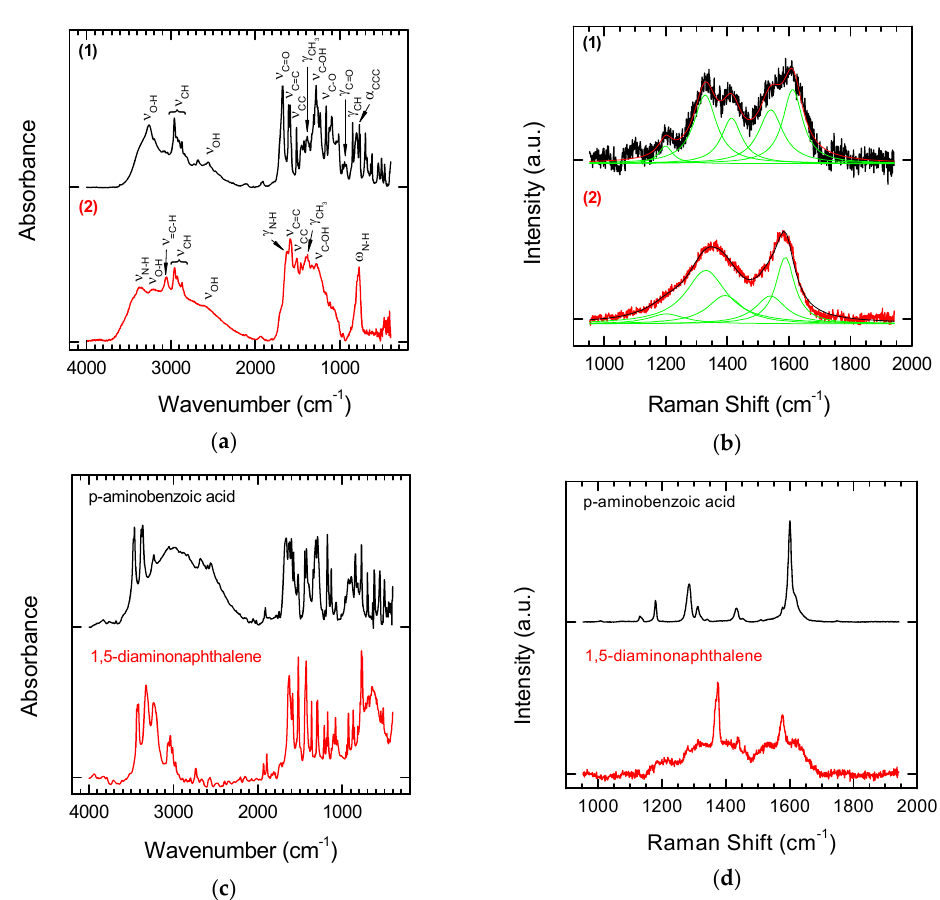
Figure 4. FT-IR ( a ) and Raman spectra ( b ) of laser treated NDPs after chemical modification with p-aminobenzoic acid (upper panel) or 1,5-diaminonaphtalene (lower panel). FT-IR ( c ) and Raman spectra ( d ) of p-aminobenzoic acid (upper panel) and 1,5-diaminonaphtalene (lower panel) used as starting materials for the modification of NDPs.